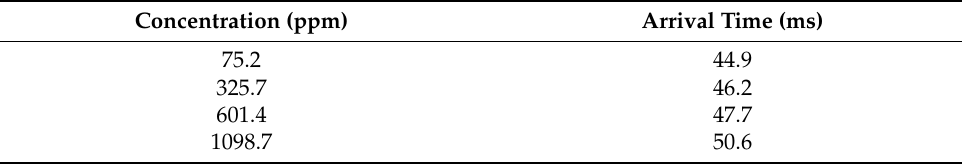
Table 2. Relationship between ethanol concentration and arrival time.